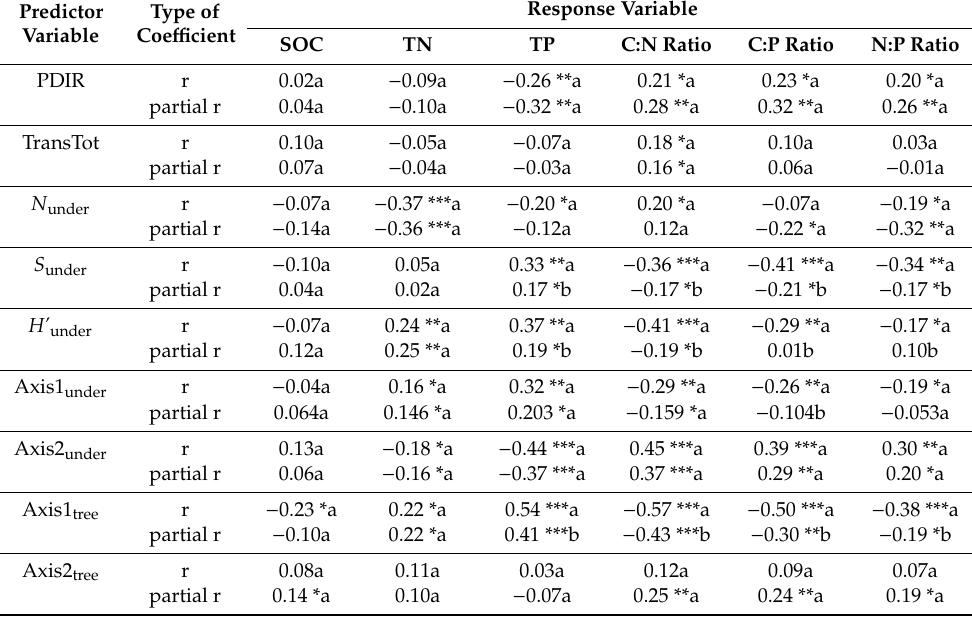
Table 3. Relationships of soil organic carbon (SOC), total nitrogen (TN), total phosphorus (TP), and C:N:P stoichiometric ratios with potential direct incident radiation (PDIR), transmitted total radiation (TransTot), and vegetation-related variables as indicated by correlation analysis (r) and partial correlation analysis (partial r) after controlling for the warming